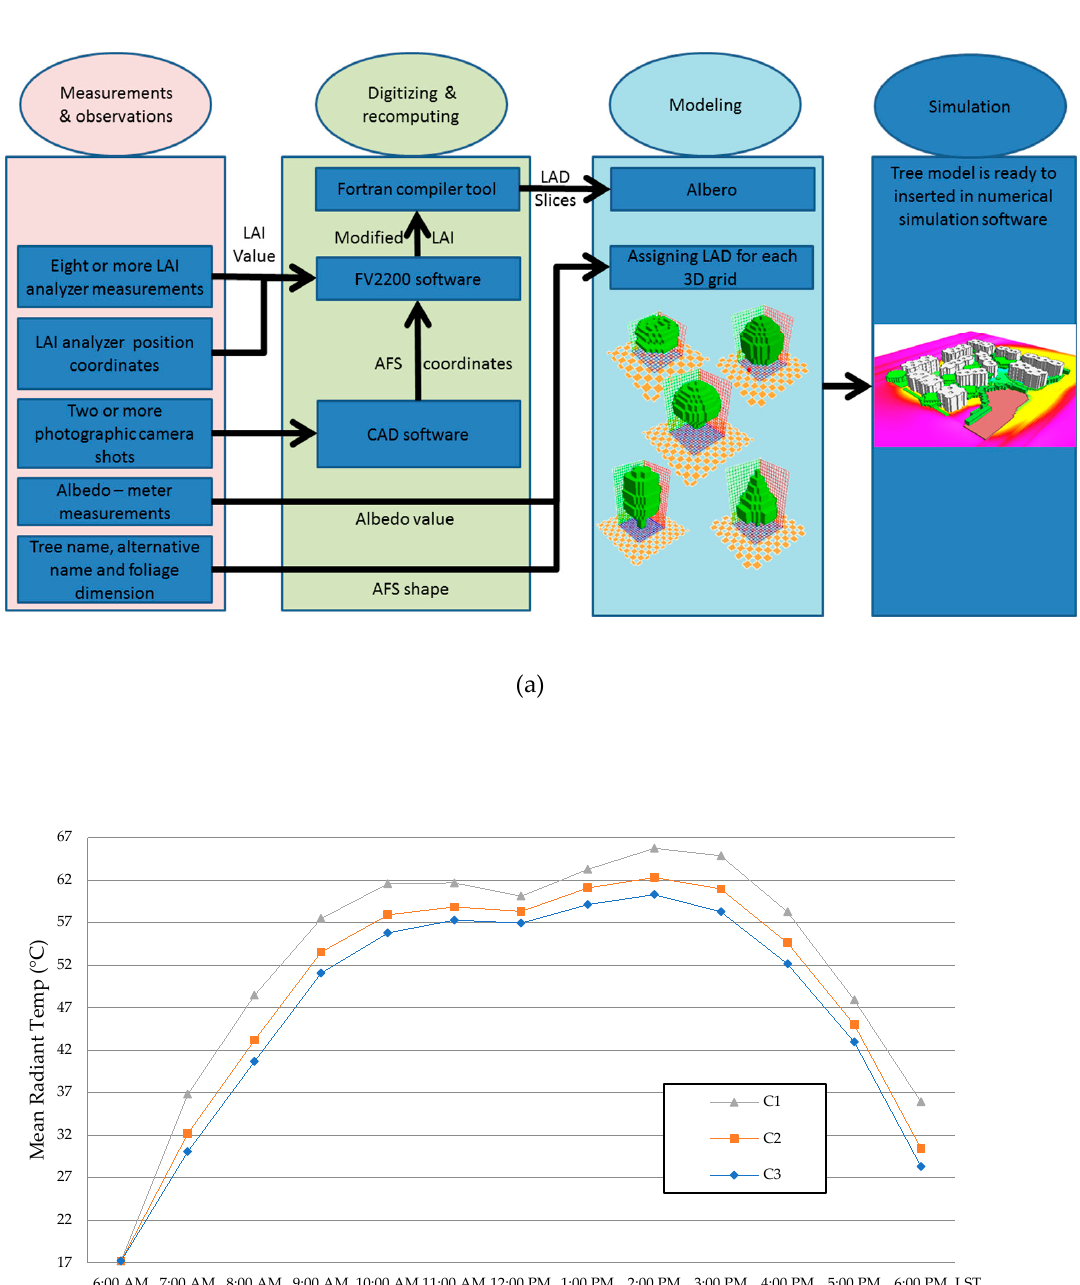
Figure 5. ( a ) Methodology of generating LAD values to simulate a single (isolated) tree in meteorology numerical simulation software, [61,70] . ( b ) T mrt comparisons between different cases of a site in Alexandria, Egypt; C1 is without trees, C2 is with trees of LAI = 1, and C3 is the site with measured LAI.